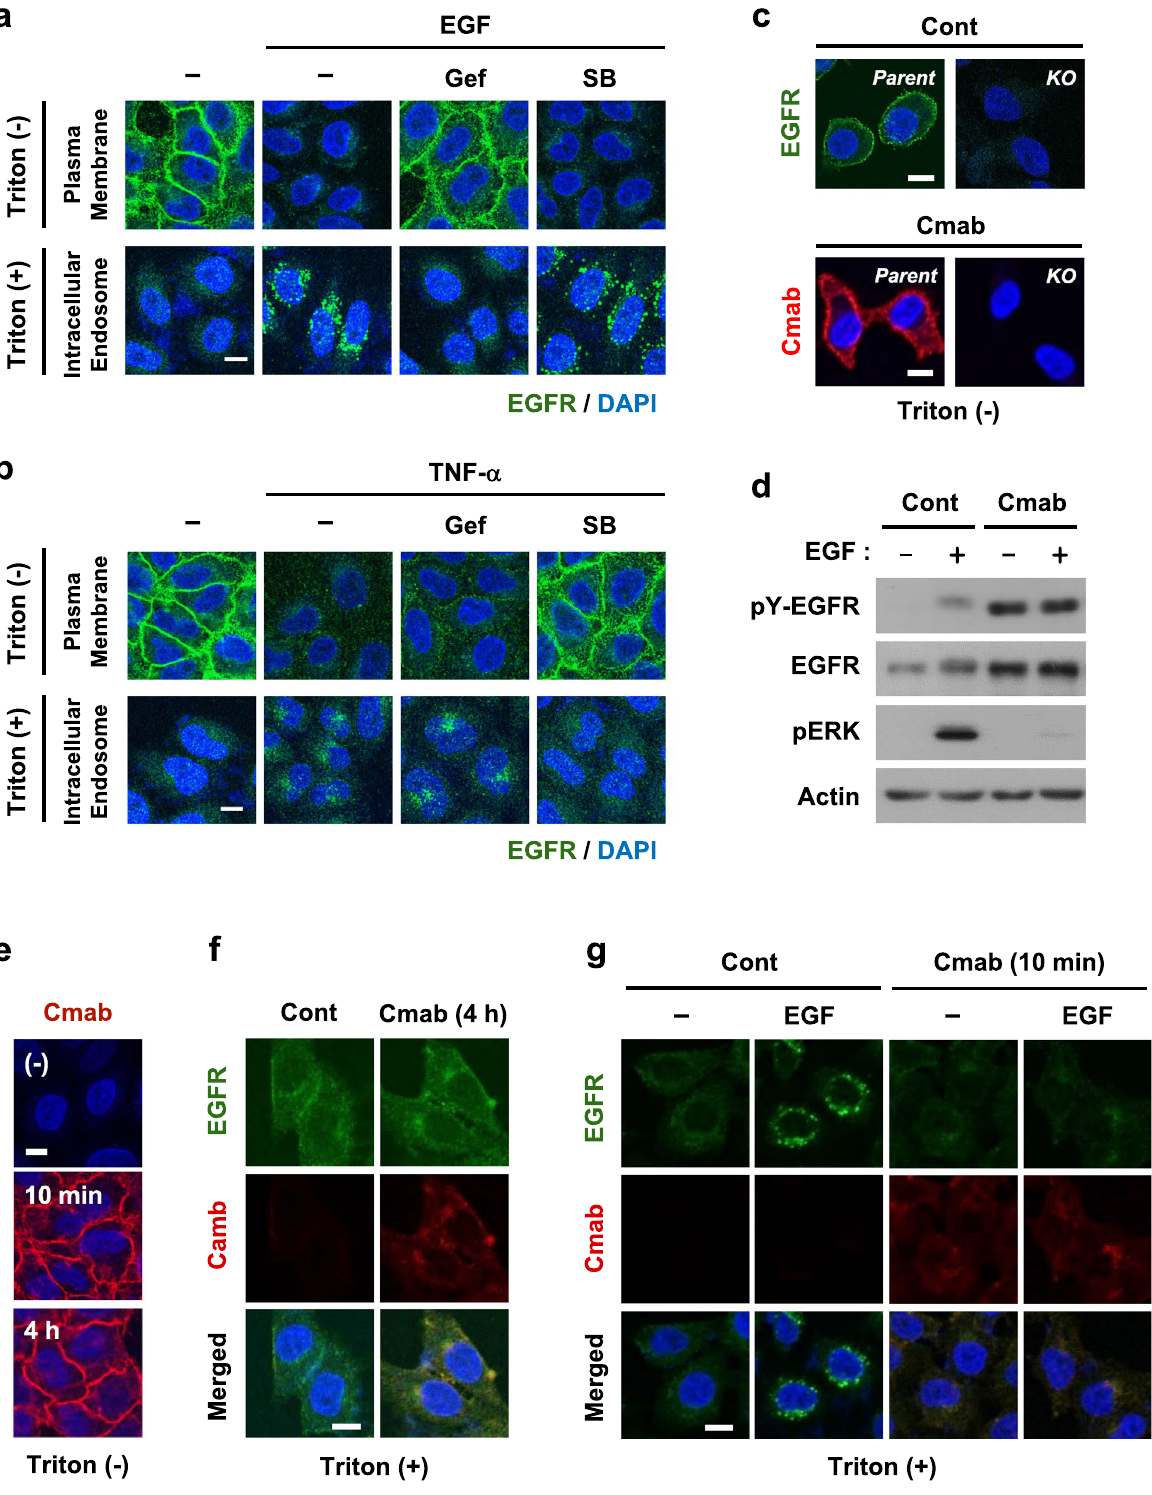
Figure 1. Cetuximab inhibits EGF-induced EGFR endocytosis. ( a , b ) HeLa cells were pretreated with 1 µM gefitinib or 10 µM SB203580 for 30 min, and then stimulated with 100 ng/mL EGF ( a ) or 20 ng/mL TNF-α ( b ) for another 15 min. The localization of EGFR on the cell surface (upper panel) or in the cytoplasm (lower panel) was investigated by immunofluorescence. DAPI, 4 ′ ,6-diamidino-2-phenylindole. ( c ) Parent HeLa cells and EGFR-knockout (KO) HeLa cells were pretreated with 100 nM cetuximab (Cmab) for 10 min. The cell surface expression of EGFR and Cmab was investigated by immunofluorescence. ( d ) Whole-cell lysates were prepared from HeLa cells stimulated with EGF for 10 min. The expression of the indicated proteins was detected by immunoblotting. pY-EGFR shows Tyr-1068-phosphorylated EGFR. Original blots are published in Supplementary Fig. S3. ( e ) HeLa cells were pretreated with 100 nM Cmab for 10 min or 4 h, and then its surface expression was investigated by immunofluorescence. ( f , g ) HeLa cells were treated with Cmab for 4 h ( f ), or pretreated with cetuximab for 10 min and then stimulated with EGF for another 15 min ( g ). The localization of EGFR and cetuximab in the cytoplasm was investigated by immunofluorescence. Scale bar = 10